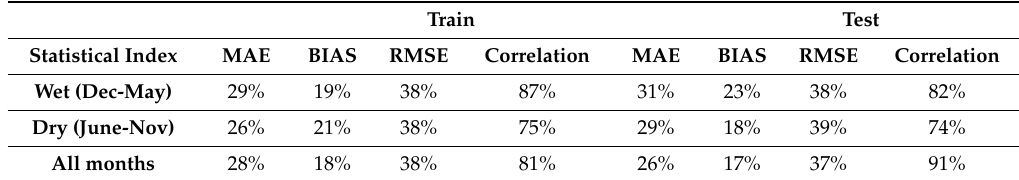
Table 2. Performance criteria of the wet and dry artificial neural network (ANN) model based on precipitation and max and min temperature data.